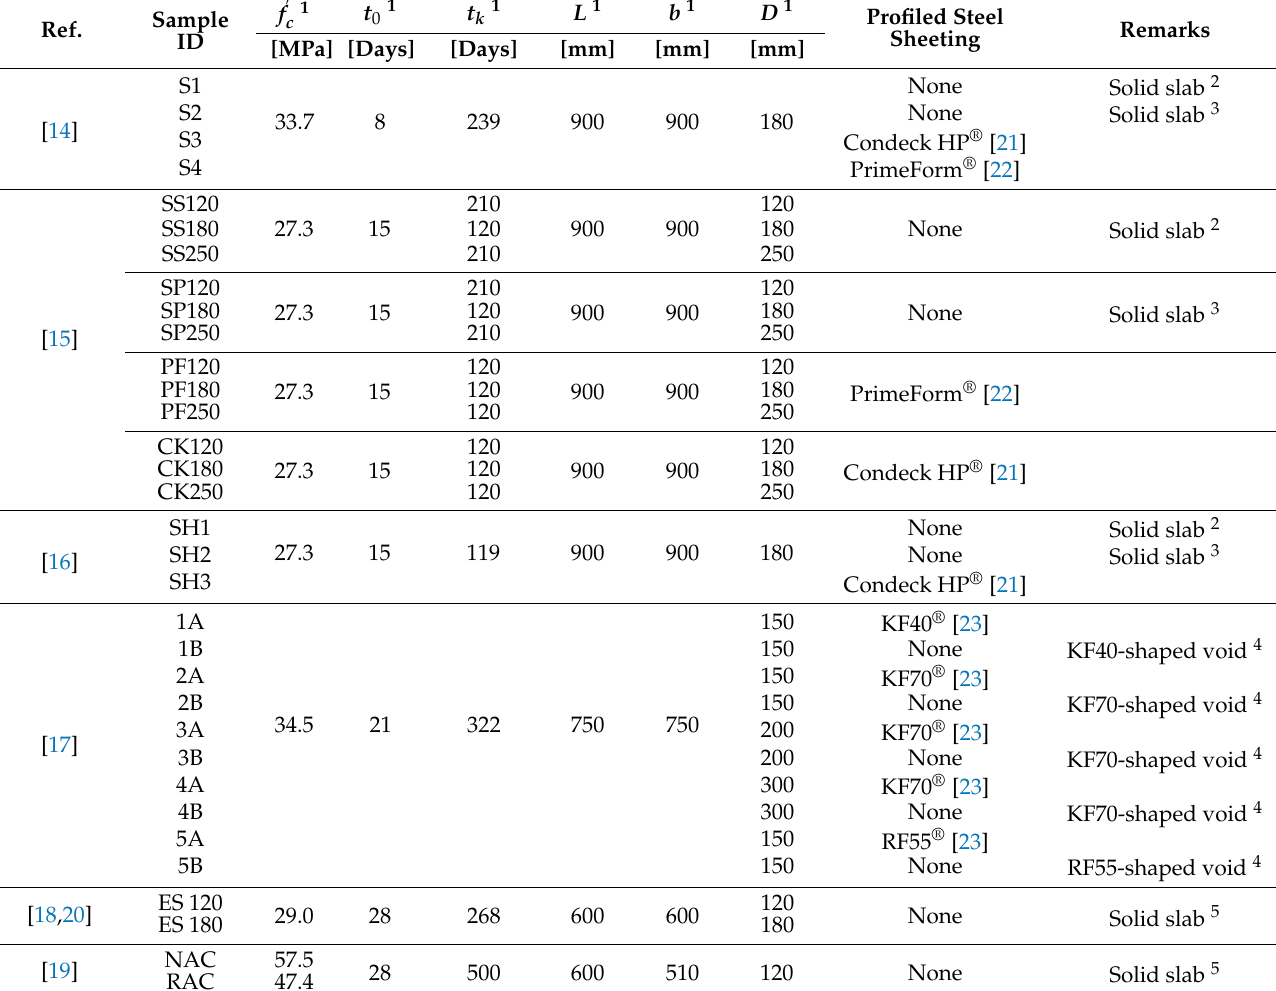
Table 1. Long-term tests of small-scale specimens to characterize shrinkage effects.